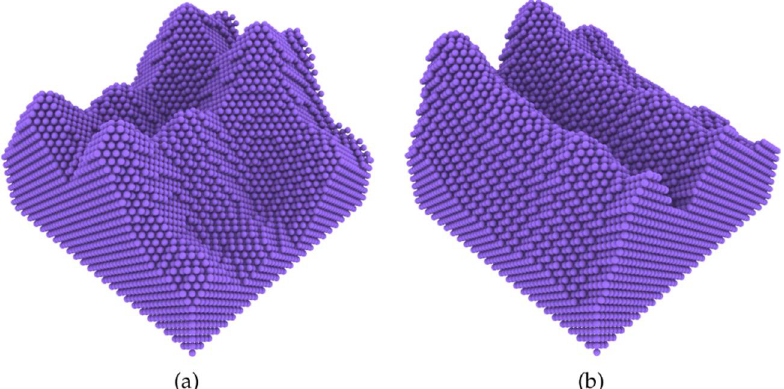
Figure 6. Rough surfaces with the highest ( a ) and lowest ( b ) ice adhesion predicted by the regres- sion SVM. Both the surfaces have an epsilon value of 0.05 eV. The rough surface in ( a ) was predicted to have an ice adhesion strength of 568 MPa, while the surface in ( b ) has a lower value of 409 MPa. The SVM showed positive results in classifying surfaces by their ice adhesion